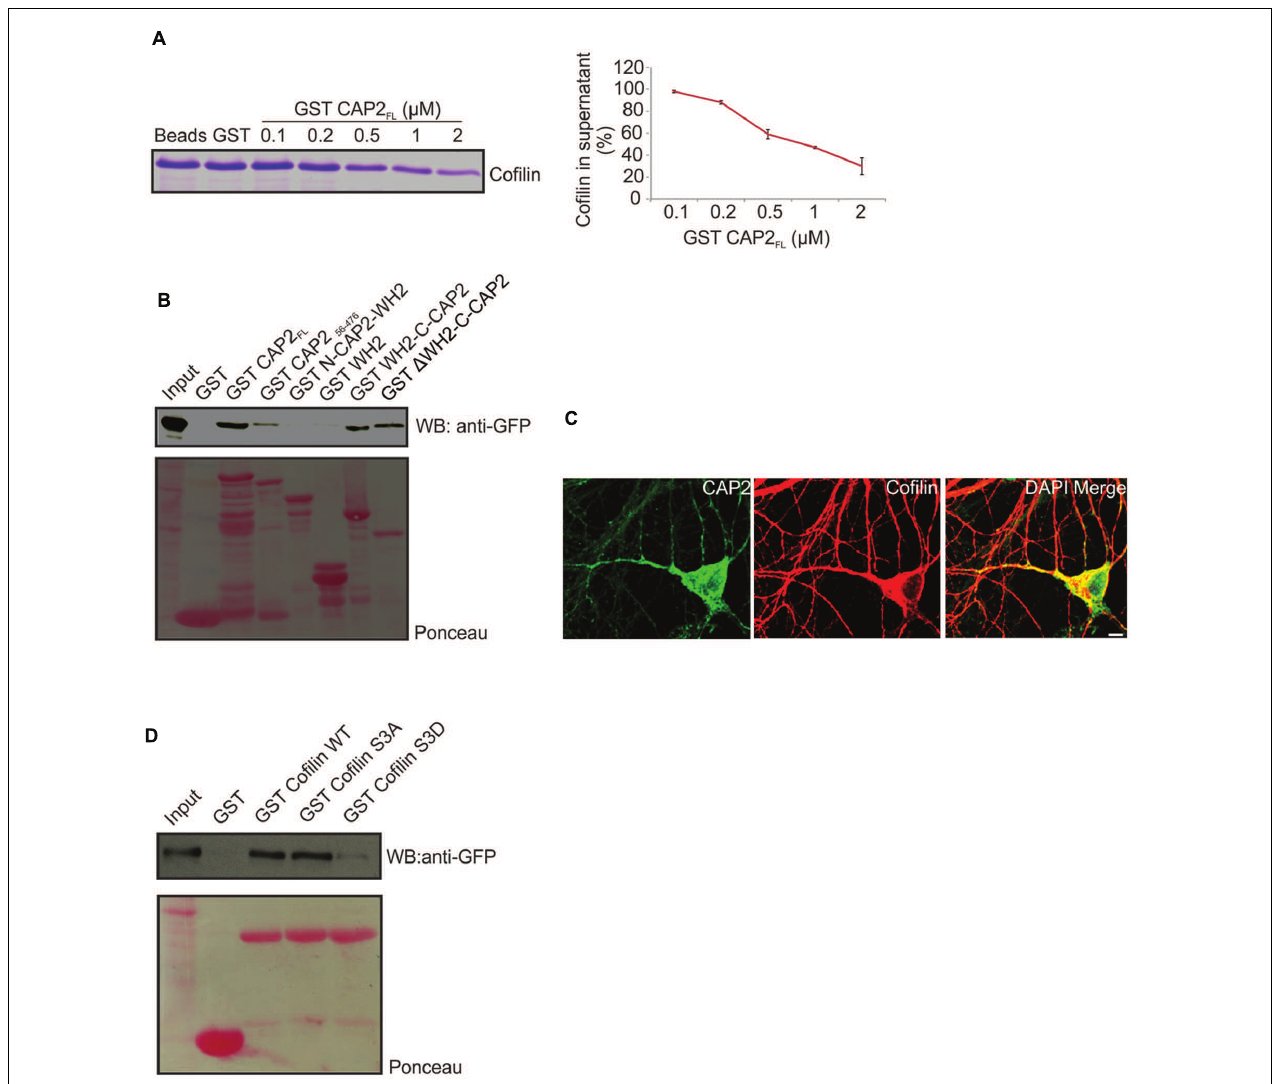
FIGURE 8 | CAP2 interacts with n-cofilin through its C-terminal domain. (A) Coomassie-stained SDS-polyacrylamide gel for the supernatant depletion pull down assay for examining the interaction between the GST-CAP2 and thrombin cleaved cofilin protein from GST-cofilin protein. The amount of cofilin in the supernatant fractions was quantified from Coomassie-stained SDS-polyacrylamide gels by densitometry analysis using Image J (GST: 1; 0.1 µ M GST-CAP2 FL : 0.98 ± 0.01; 0.2 µ M GST-CAP2 FL : 0.88 ± 0.02; 0.5 µ M GST-CAP2 FL : 0.59 ± 0.04; 1 µ M GST-CAP2 FL : 0.47 ± 0.01; 2 µ M GST-CAP2 FL : 0.3 ± 0.07; n = 3). (B) Pull-down experiment with ectopically expressed pEGFP-C2 n-cofilin. Precipitated proteins were detected by western blotting using monoclonal anti-GFP. Ponceau staining of the nitrocellulose membrane as loading control for the pull down assay. GST was used as a control. CAP2